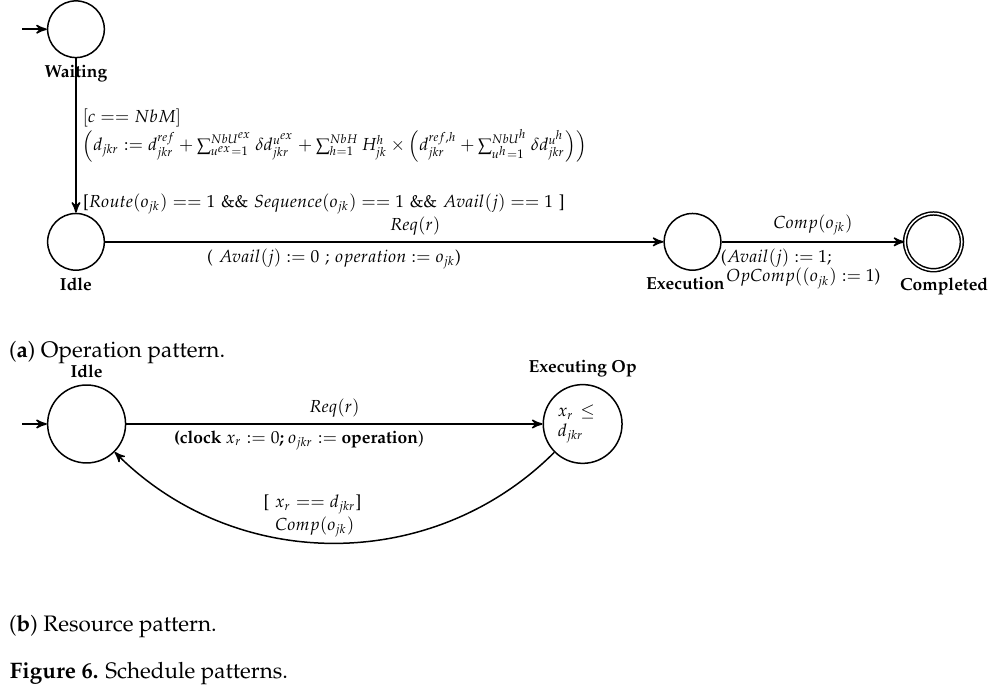
Figure 6. Schedule